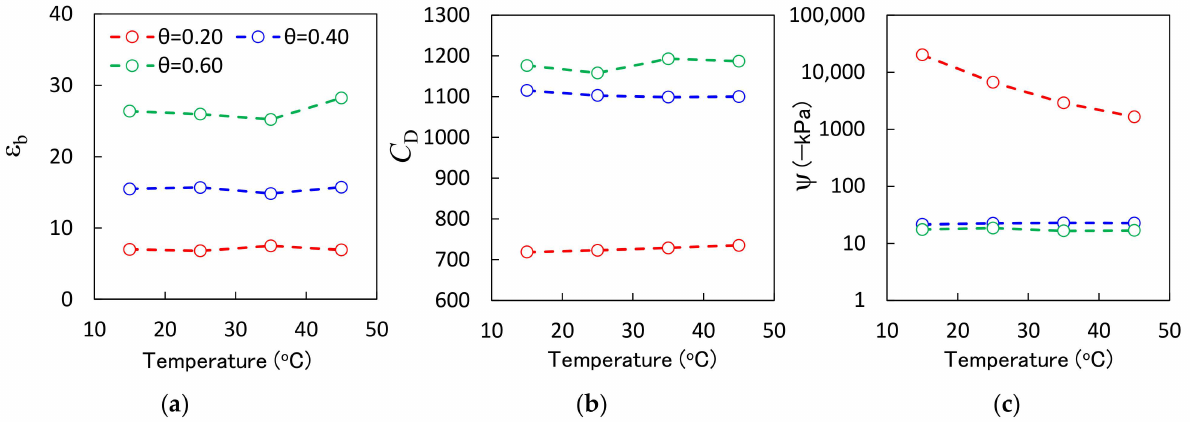
Figure 6. ( a ) The new sensor-measured dielectric constant ( ε b ), ( b ) digital values of the new sensor- measured capacitance ( C D ), and ( c ) the new sensor-measured matric potential ( ψ ) as functions of the temperature. The colored plot indicates the different water content ( θ ) of the Andisol, i.e., 0.20 m 3 m − 3 , 0.40 m 3 m − 3 , and 0.60 m 3 m − 3